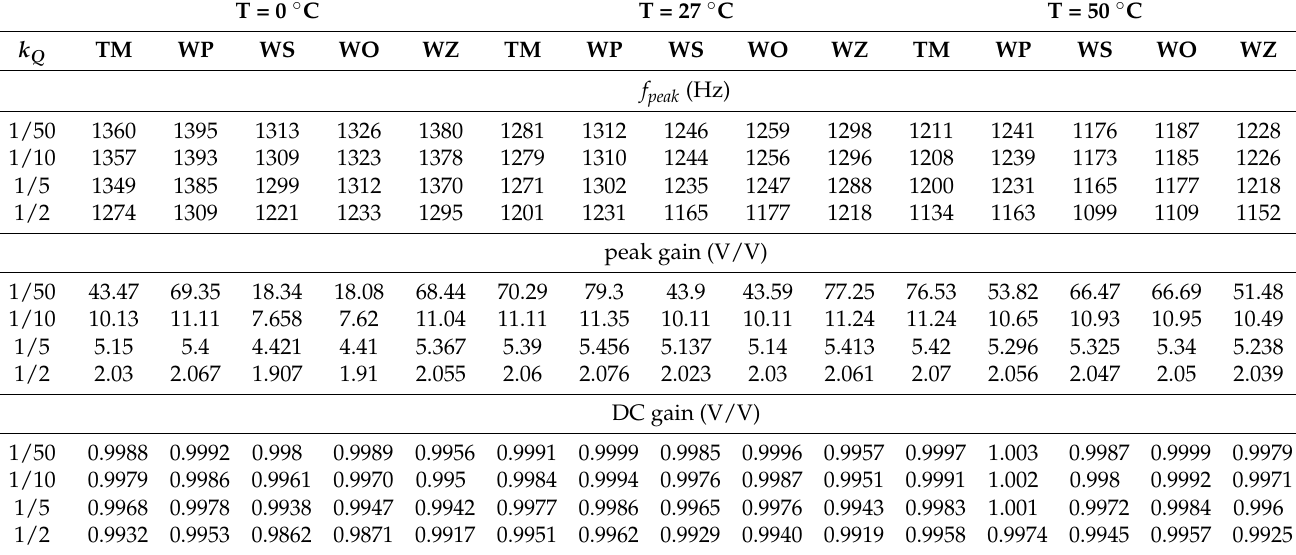
Table A1. Corner simulation results for the middle-band filter at V DD of 0.5 V.